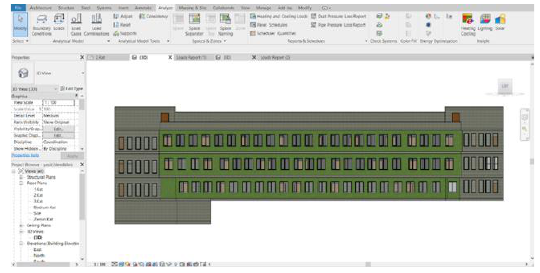
Figure 19 R2 Classrooms building eastern facade view with vertical green system applied